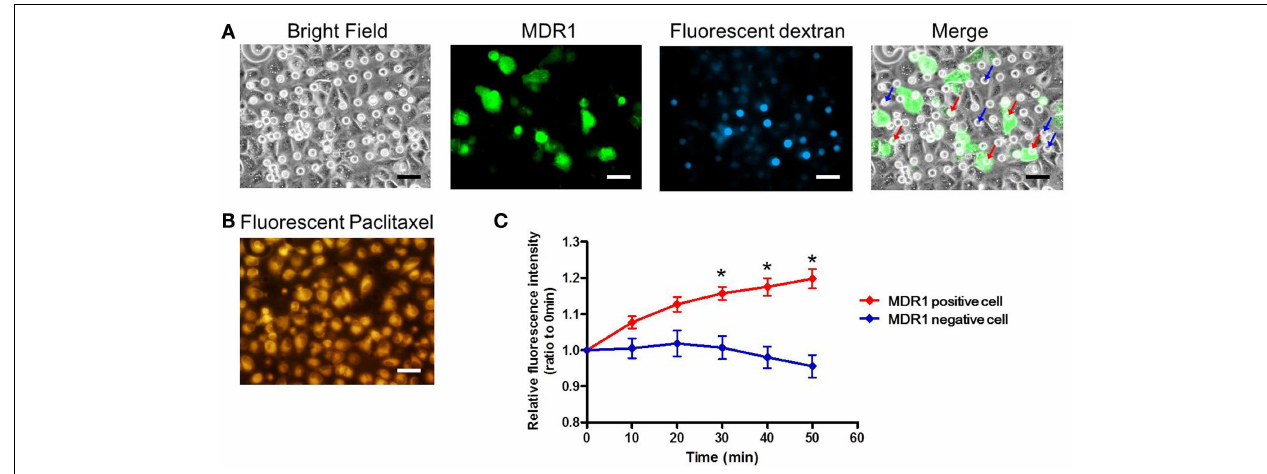
microchambers covered by MDR1 positive cells (red line) and MDR1 negative cells (blue line), both retaining dextran. Each line represents the average of five independent chambers indicated by the arrows with corresponding colors in the merged image. Data are presented as the mean ± SEM. * P < 0.05 by Student’s t -test. All scale bars in micrographs represent 50 µ m.